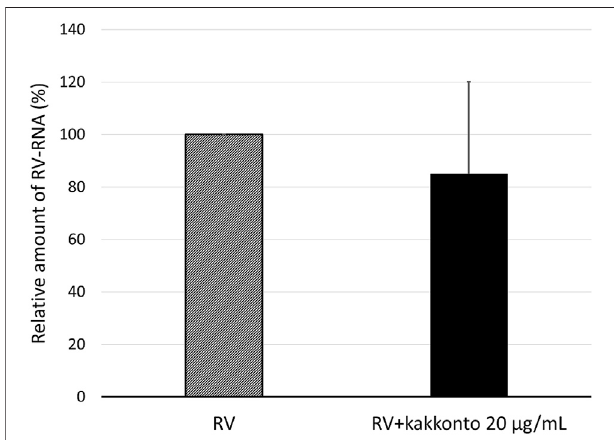
FIGURE 4 | Relative amount of RV14 RNA in HNE cells treated with 20 μ g/ml kakkonto compared to cells cultured in medium alone 24 h after infection. Results are expressed as the relative amount (%) compared to that of cells cultured in medium alone and presented as mean ± standard